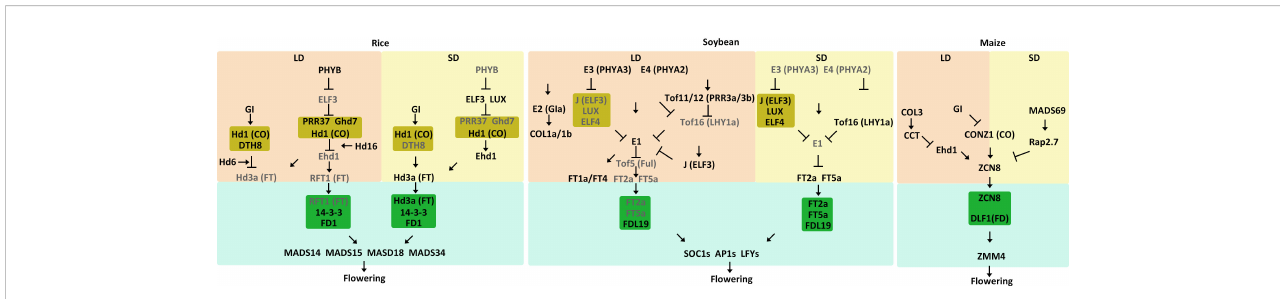
FIGURE 3 Model of fl owering time control pathways in major SD crops. The different external and internal cues are highlighted in different colors. Positive and negative regulatory actions are indicated by arrows and lines with bares,